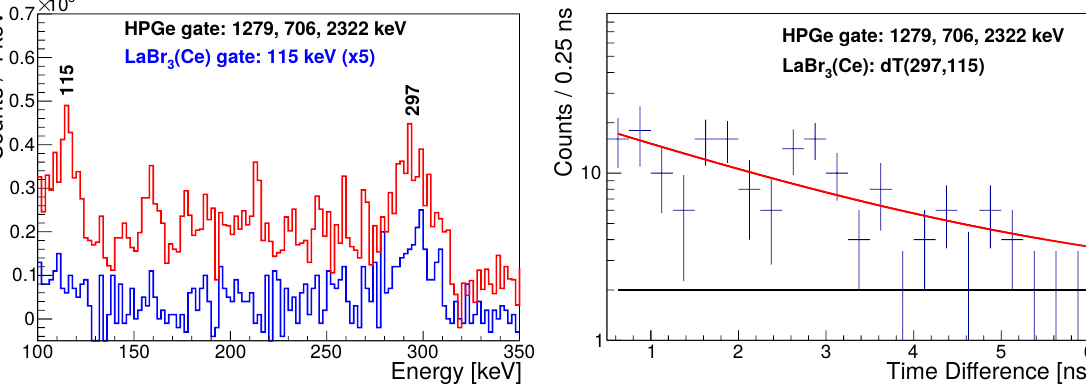
Figure 1. Left: Delayed LaBr 3 (Ce) energy projection after applying a HpGe gate on several transitions in 134 Te (red) and an additional LaBr 3 (Ce) gate on 115 keV (blue). Right: Time di ff erence of the 297 - 115 keV cascade to measure the half-life of the 4 + The distribution was fitted using an exponential decay (red) plus a constant background (black).